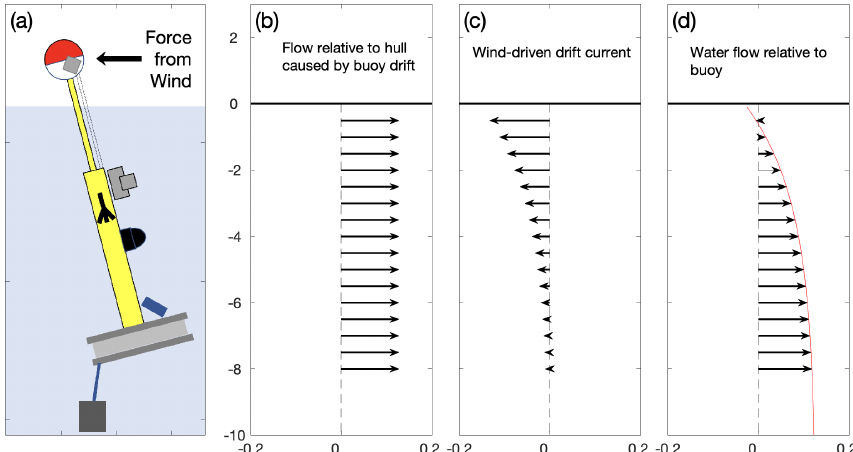
Figure A4. The combination of influences contributing to the water flow profile in the frame of reference of the buoy. Panel (a) shows the buoy oriented into the wind, with the dome acting as an obstacle to the wind and transferring horizontal force to the submerged hull. Panel (b) shows the effect of flow speed relative to the buoy caused by the buoy moving through the water in response to a 15ms − 1 wind. Arrow length represents water flow speed and the magnitude is shown on the x axis in ms − 1 . Panel (c) shows the current due to Stokes drift, calculated as described in the main text. Panel (d) shows the combination of (b) and (c) relative to the buoy hull. The red line shows the complete